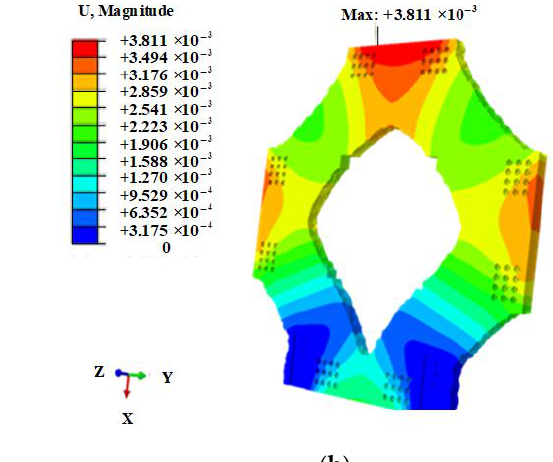
Figure 4. Composition of the high-temperature/biaxial loading module frame support.